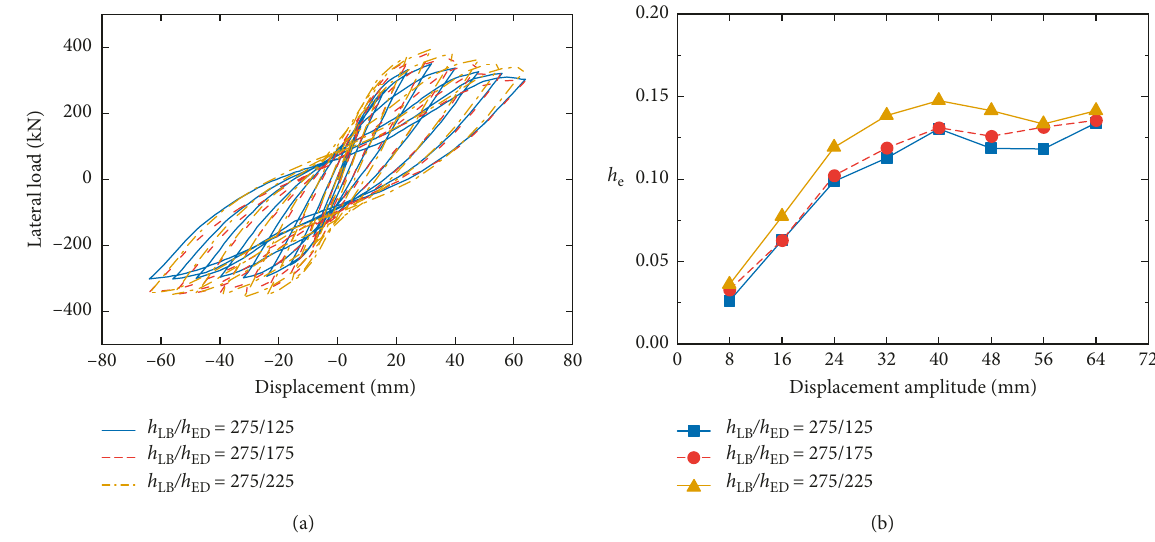
Figure 24: Effect of the sectional heights of the SCB. (a) Hysteresis curves. (b) Equivalent viscous damping ratio.